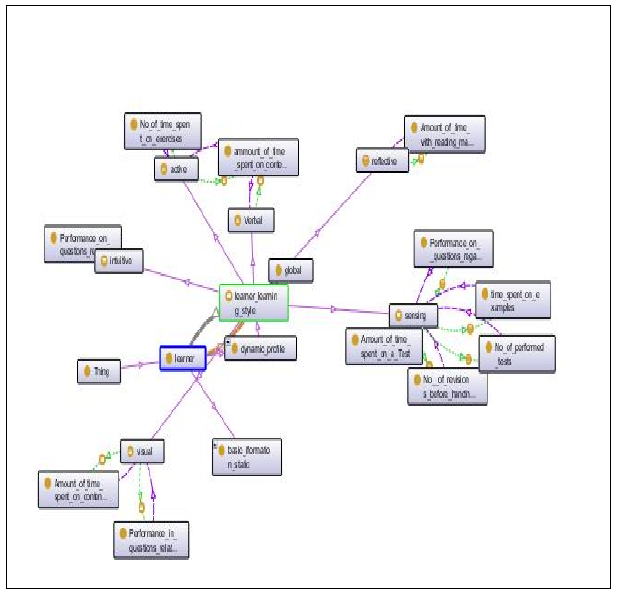
Figure 11. Modeling the relationship between